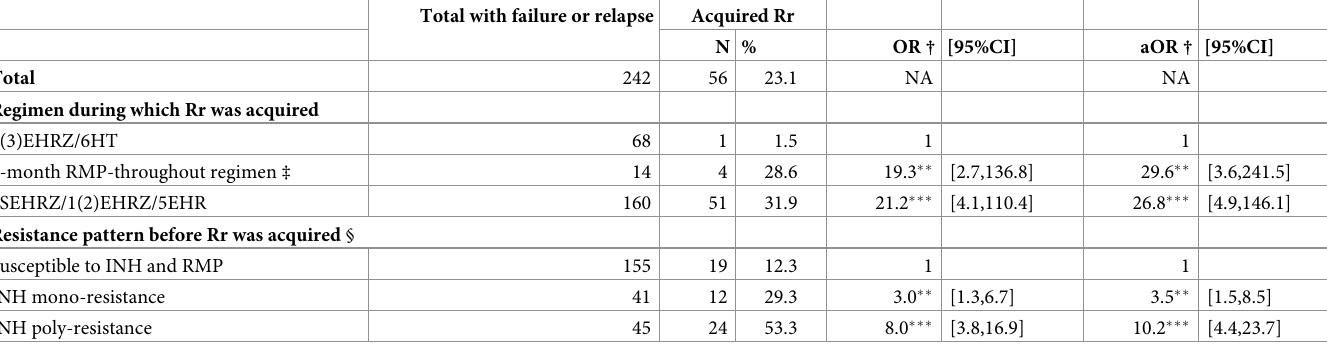
Table 5. Predictors of acquired rifampicin resistance in 242 treatment failure and relapse patients with initially rifampicin-susceptible